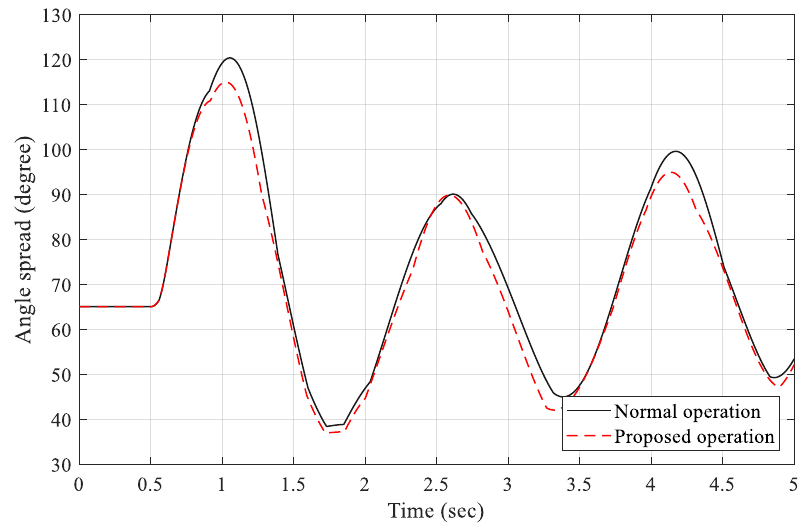
Figure 14. The angle spread for the generation side event.